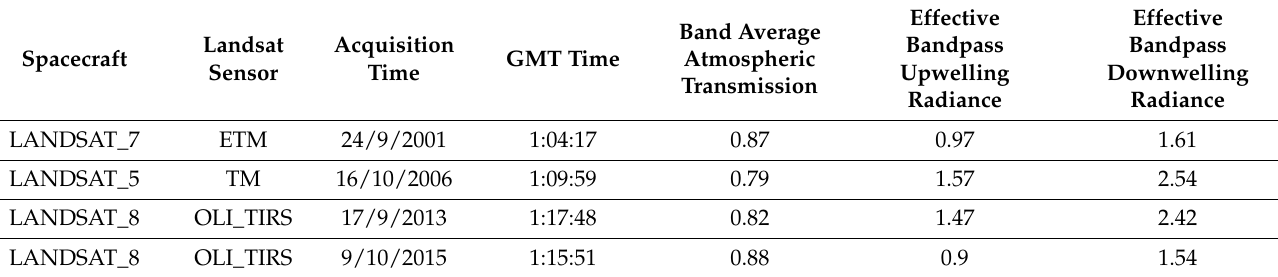
Table 2. Specifications of Landsat data used in this